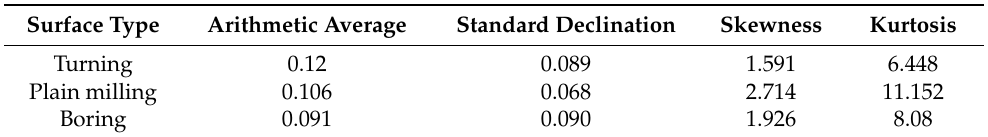
Table 3. Distribution characteristic index of the normal declination angle of Ra 0.8 µ m sample surface